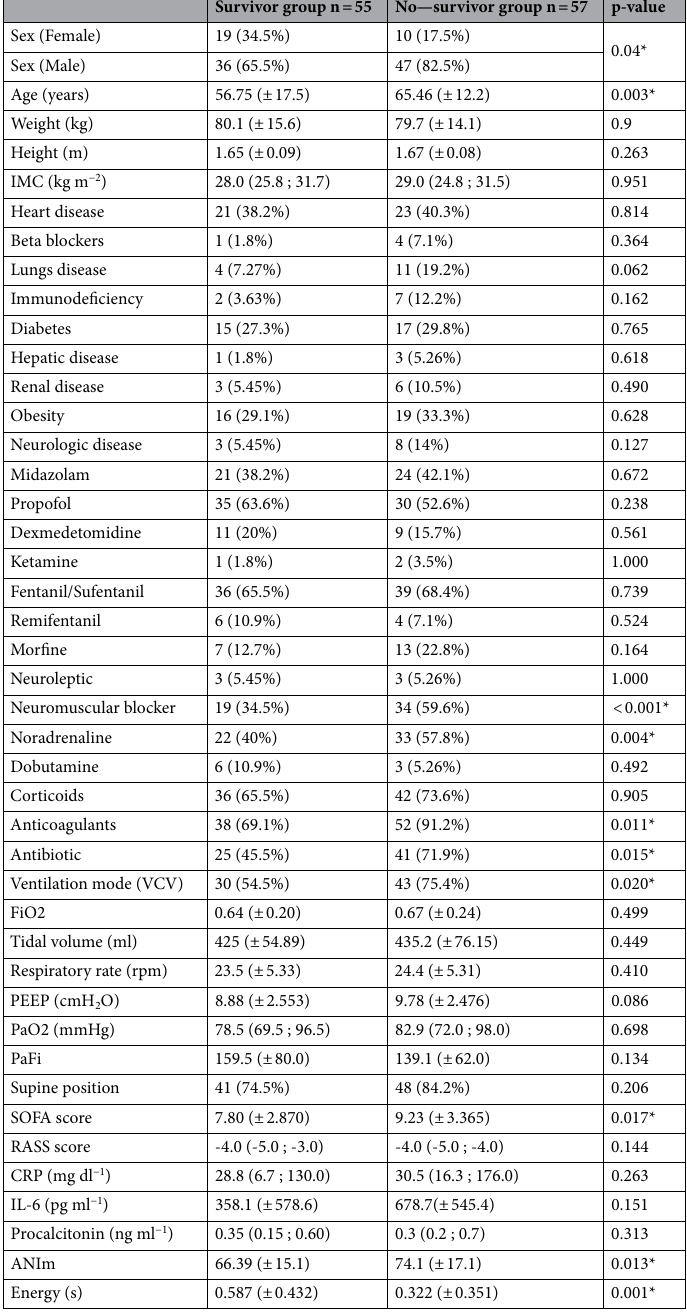
Table 1. Homogeneity and comparison of demographic and characteristics data between groups. Basic descriptives and tests for the demographic and characteristics variables for each group. Absolute (N) and relative (%) frequencies for the qualitative variables. Normally distributed quantitative variables are expressed as Mean (Standard deviation) and non-normally distributed quantitative variables are express as median and quartiles (1st; 3rd). P values were calculated using Student’s t-test and Mann–Whitney tests. SOFA, Sequential Organ Failure Assessment; RASS, Richmond Agitation-Sedation Scale; CRP, C-reactive protein; IL-6, Interleukin-6; VCV, Volume-controlled ventilation; FiO2, Fraction of inspired oxygen; PEEP, positive end expiratory pressure; PaO2, partial pressure of oxygen in arterial blood; ANIm, mean analgesia nociception index. *Significance defined as p-value <